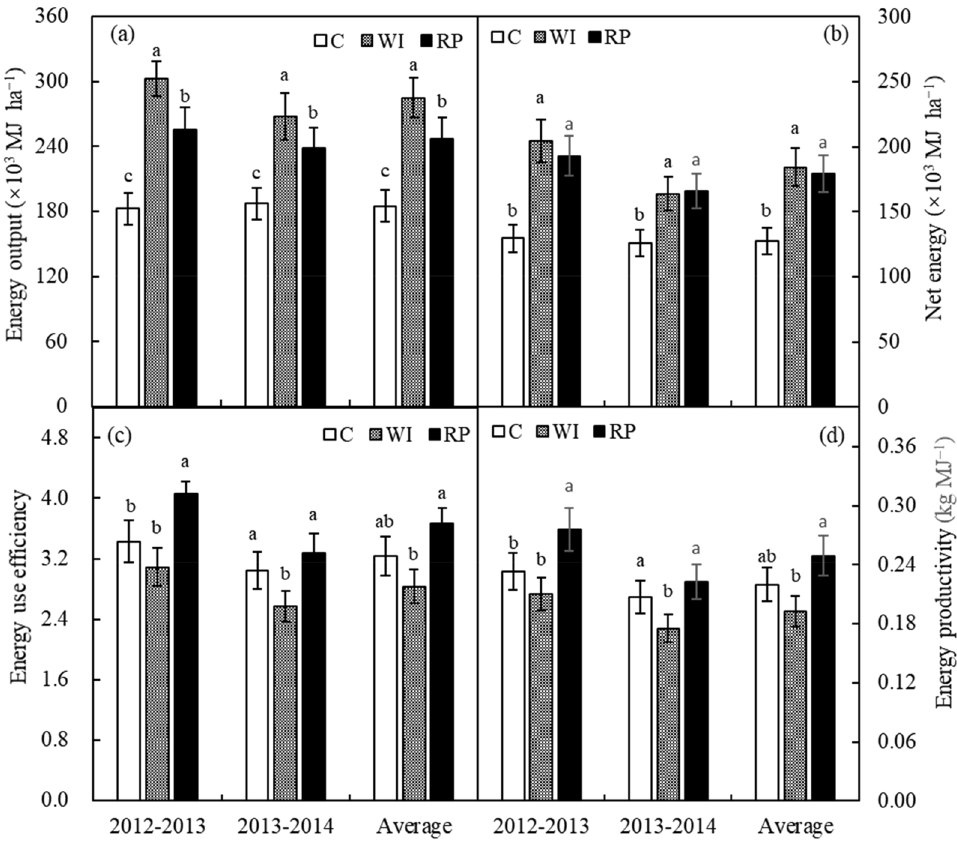
Figure 3. Effect of different planting strategies on energy output ( a ), net energy output ( b ), energy use efficiency ( c ), and energy productivity ( d ) of wheat–maize cropping